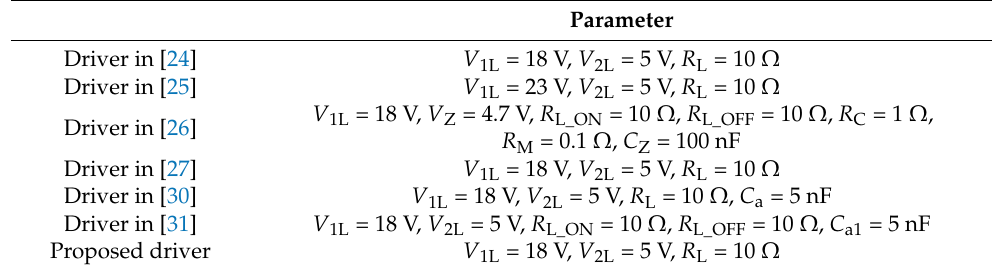
Figure 8. Simulation results of the prior drivers in [24–27,30,31] and the proposed driver. ( a ) the conventional driver in [24], ( b ) driver in [25], ( c ) driver in [26], ( d ) driver in [27], ( e ) driver in [30], ( f ) driver in [31] and ( g ) the proposed driver. Table 3. Parameters of prior drivers in [24–27,30,31] and the proposed